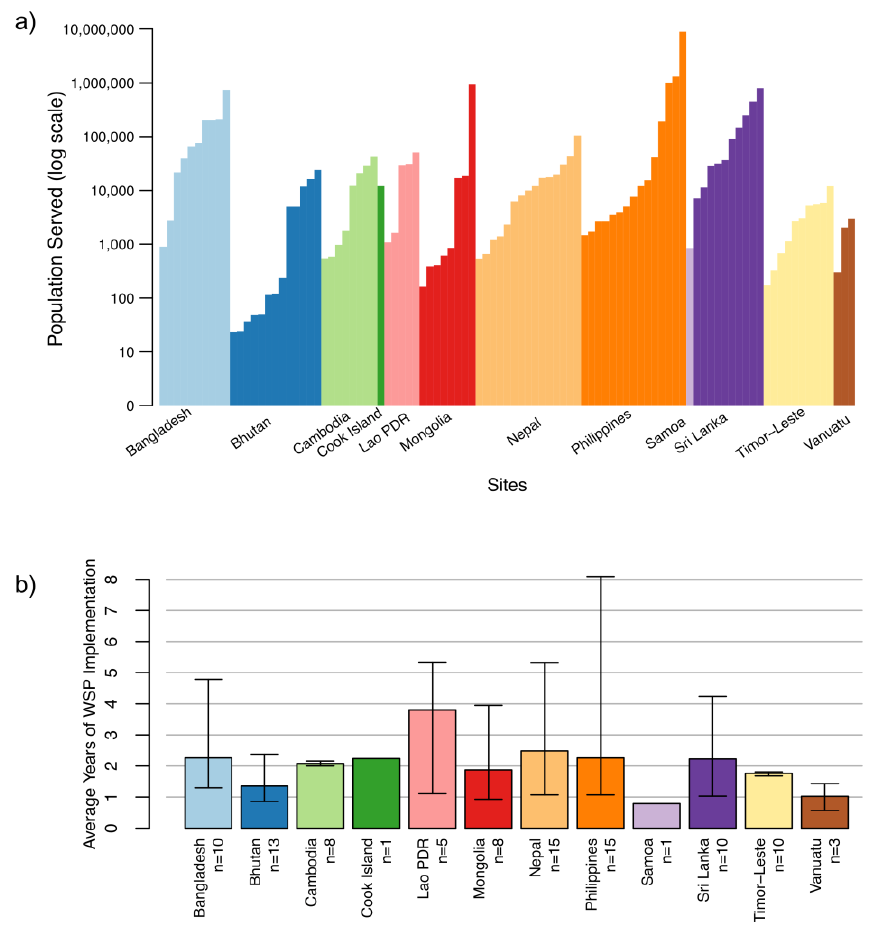
Figure 2. Description of sites: ( a ) Populations served by sites; ( b ) Mean age of WSP at time of follow-up data collection. The upper and lower bounds show the maximum and minimum ages in each country, respectively.